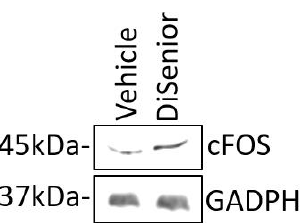
Figure 4. Disenior TM increases neuronal activity. Immunoblot of cFOS level in hippocampal neurons (21DIV) treated with Disenior TM .